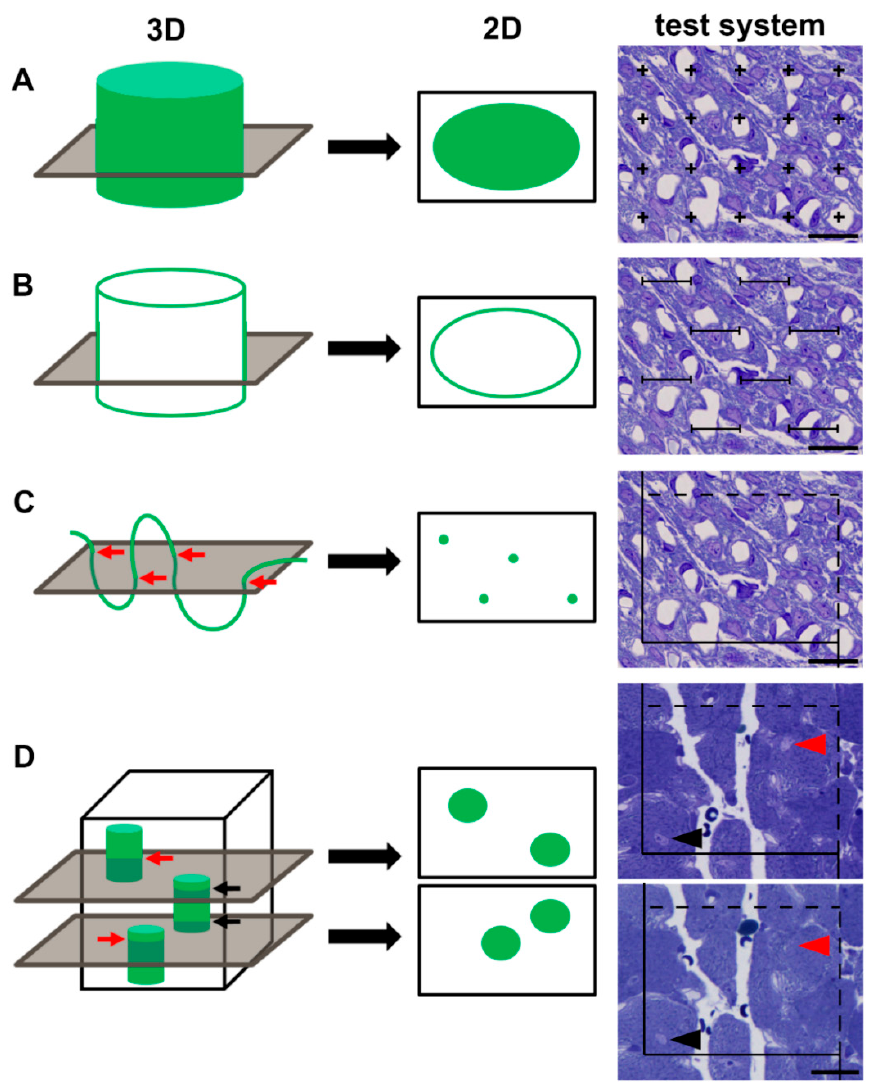
Figure 1. Structural parameters, their representation in 2D sections, and their estimation by stereo- logical test systems. ( A ) A 3-dimensional (3D) volume appears as a 2-dimensional (2D) area in histological sections, and can be quantified by point probes; ( B ) a surface area of a 3D object appears as a 2D boundary line in histological sections, and can be quantified by line probes; ( C ) the length of a 3D object is represented by 2D profiles or transects (red arrows) in histological sections, and can be quantified by plane probes such as counting frames; ( D ) the number of objects is not represented in one histological section, but as particle tops or ends in a volume between two 2D sections, and can be quantified by plane probes and counting particles visible in one section, but not in the other (red arrows, red arrowheads). Objects transecting both sections appear as profiles on both sections and are not counted (black arrows, black arrowheads). Scale bar: 20 µm.